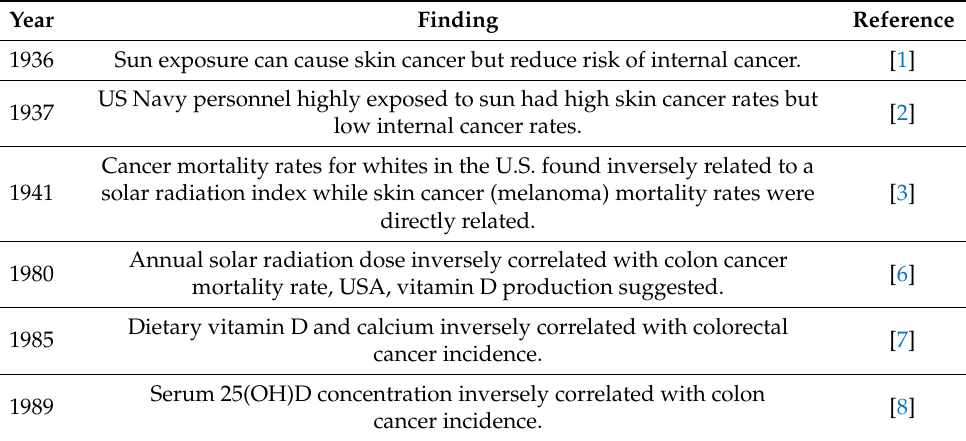
Table 10. List of epidemiological studies that had important findings in the history of solar UVB exposure and/or vitamin D and